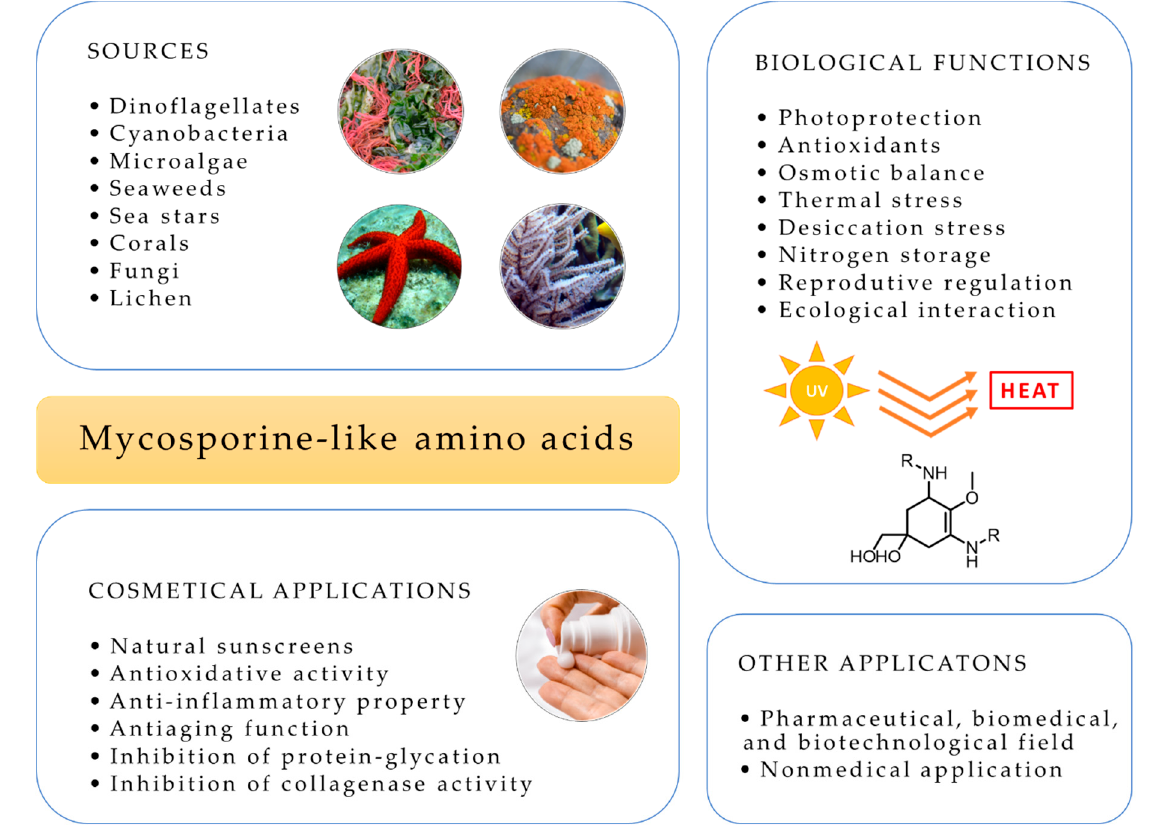
Figure 4. Mycosporine-like amino acids sources, biological functions and applications.